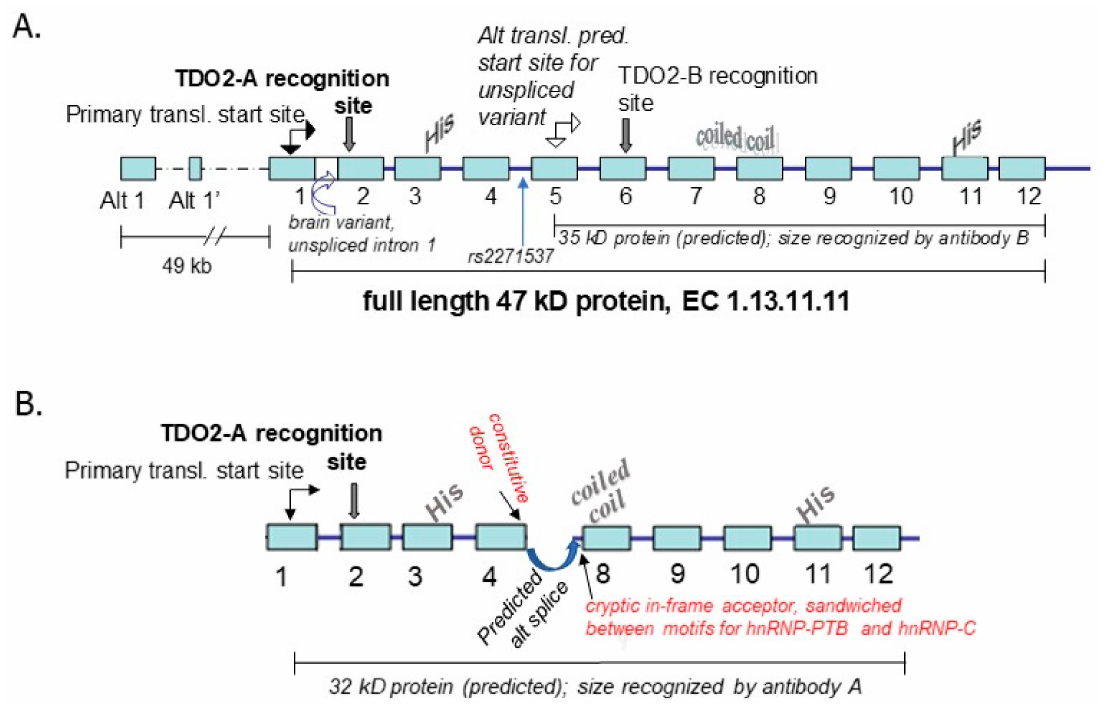
Figure 6. Isoforms of TDO2 in the brain, recognized by antibodies directed to different epitopes, TDO2-A and TDO2-B; the specificity of antibody A for TDO2 confirmed by Schmidt et al. [164] in a Western blot of recombinant human TDO2. Epigenetic regulation of these isoforms is likely. ( A ). Experimental evidence derived from sequencing a cDNA clone of a brain transcript that retained intron 1, supports the existence of isoform TDO2-B, as two ORF finding programs (™DNAstar, NCBI) revealed this intron-1-retained sequence shifts the predicted start site to an ATG in exon 5; the resulting protein would be 35 kD as seen in the Western blots. The location of the SNP for a genetic association study, rs2271537 [65] is indicated. ( B ). In silico prediction of one potential identity